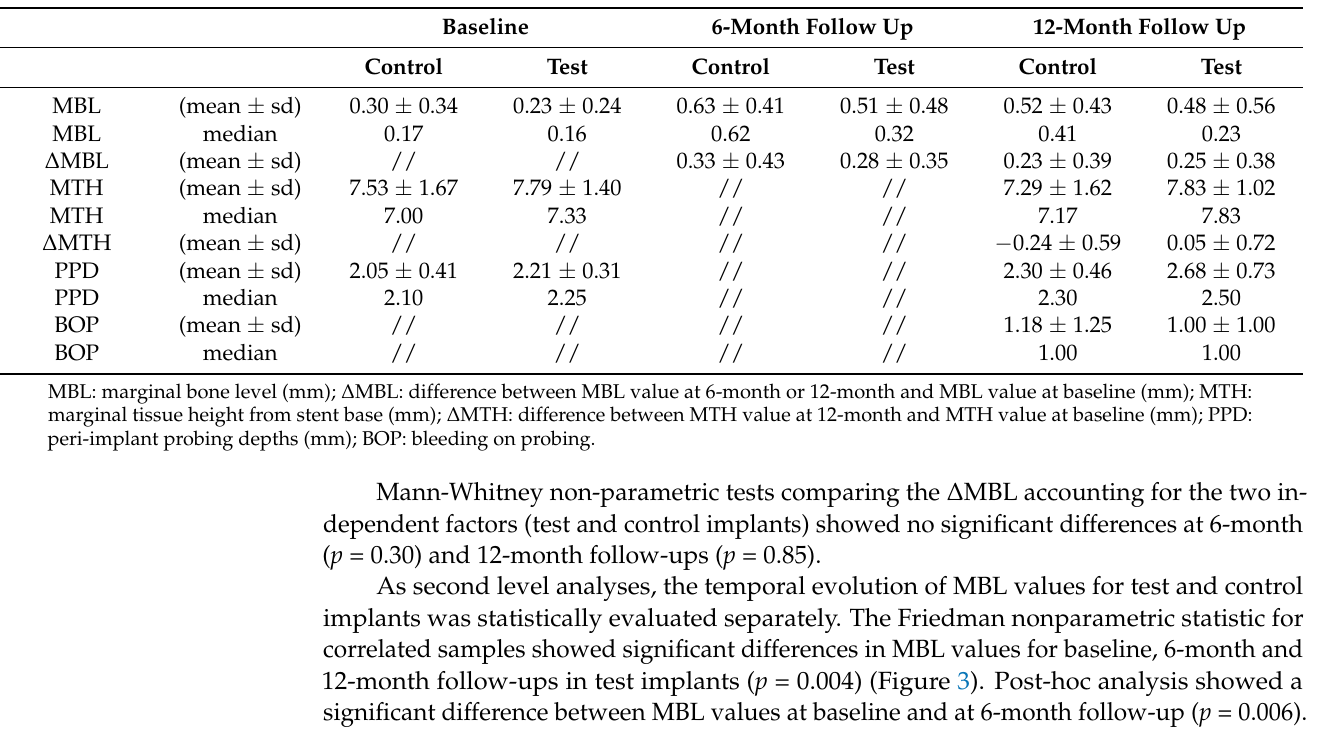
Table 2. Mean ± sd and median for the temporal evolution of all clinical outcomes.